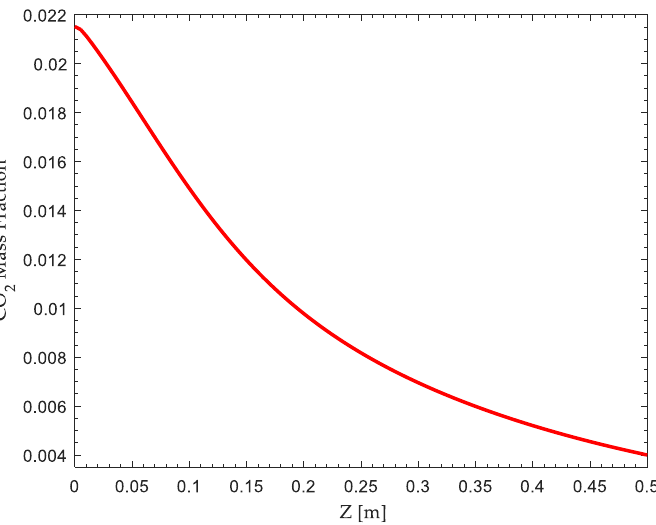
Figure 14. Axial CO 2 mass fraction profile at representative tube centerline (0.5-m reactor module) under 7-m 3 /h thermal oil feed rate.